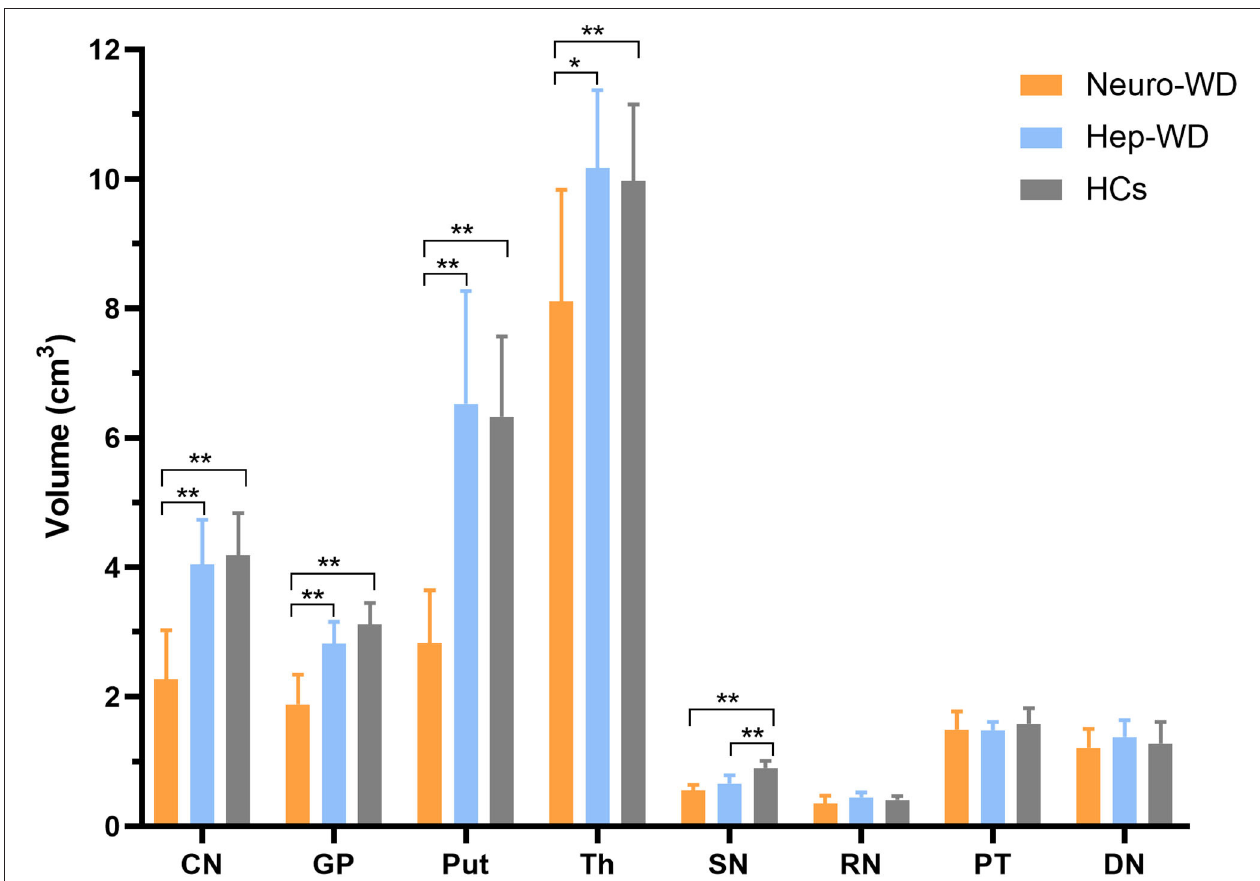
FIGURE 4 | Comparison of volumes of deep gray matter nuclei between different groups. Comparison between healthy control (HCs) and patients with WD: * p < 0.017 and ** p < 0.001. Comparison between patients with neuro-WD and patients with hep-WD. Error bars indicate standard deviation. CN, head of the